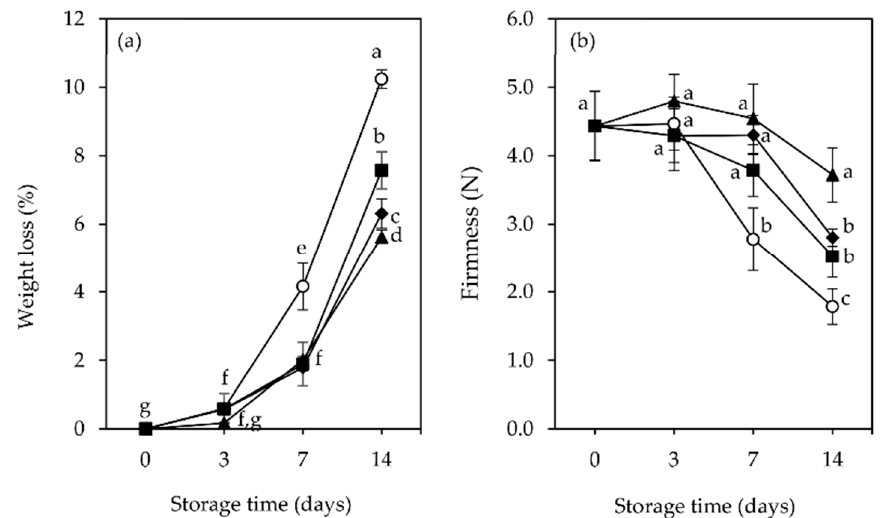
Figure 3. Changes in weight loss ( a ) and firmness ( b ) of packaged raspberry ( Rubus idaeus L. cv. ‘Kweli’) fruits (no film-pad _Ctr, ○ ; with film-pad containing green tea extract_Ch + GTE, ◆ , rosemary extract_Ch + RSME ▲ , only chitosan ■ ), stored for 14 days at 4 °C under passive MAP conditions. Vertical bars indicate standard deviation of five replicates. Means with equal letters are not statistically different by Tukey’s test with 5% significance level.